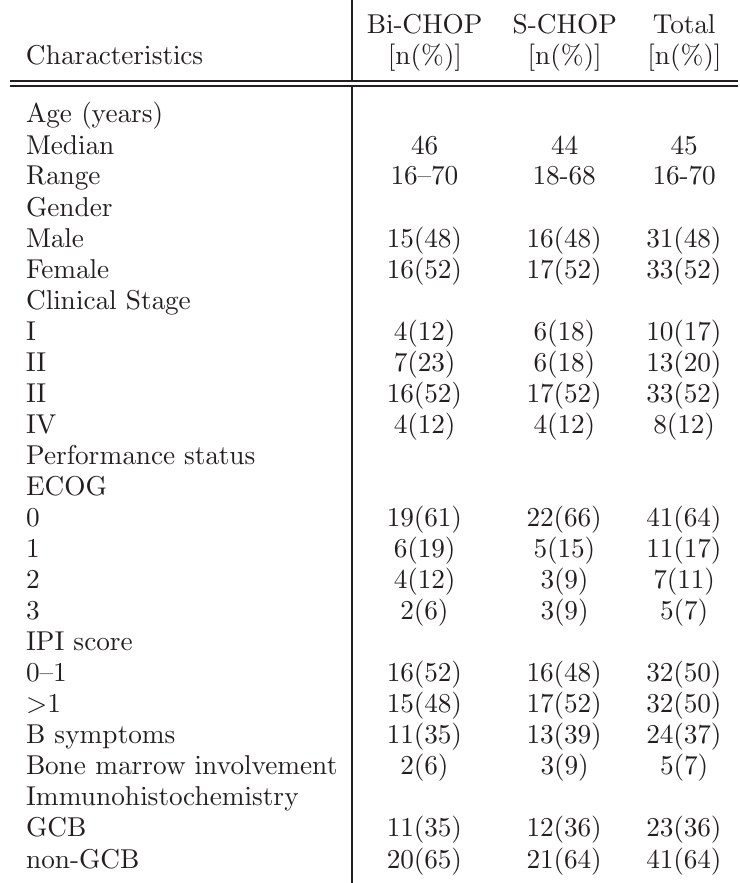
Table 1 Clinical characteristics of the 64 eligible patients of the study, subdivided by treatment